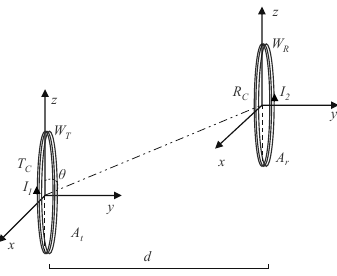
Figure 1. Principles of magnetic induction communication.